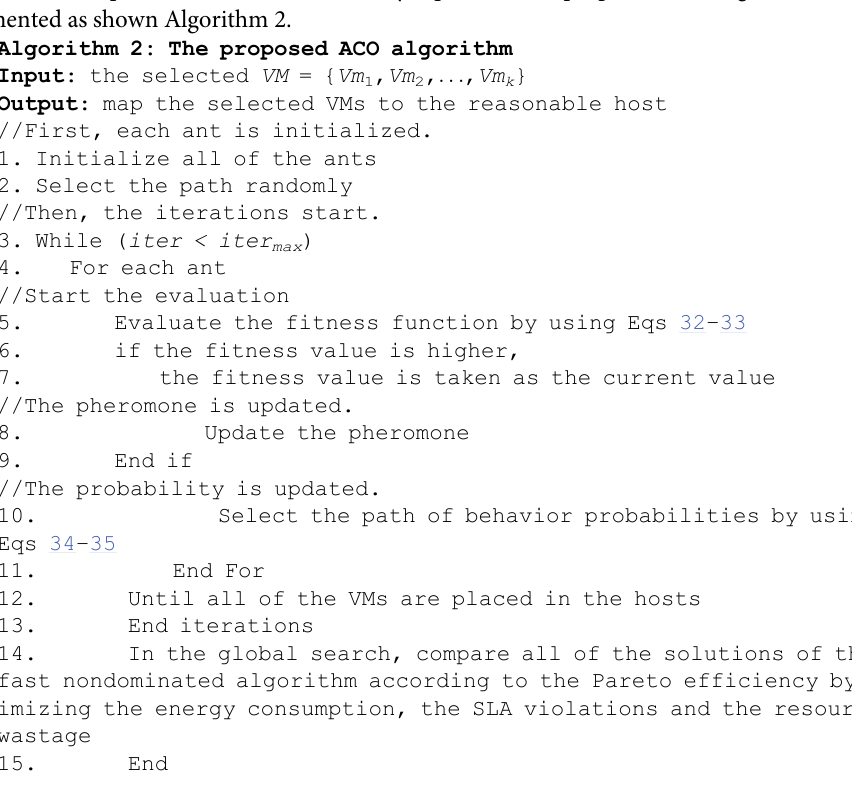
Algorithm 2: The proposed ACO